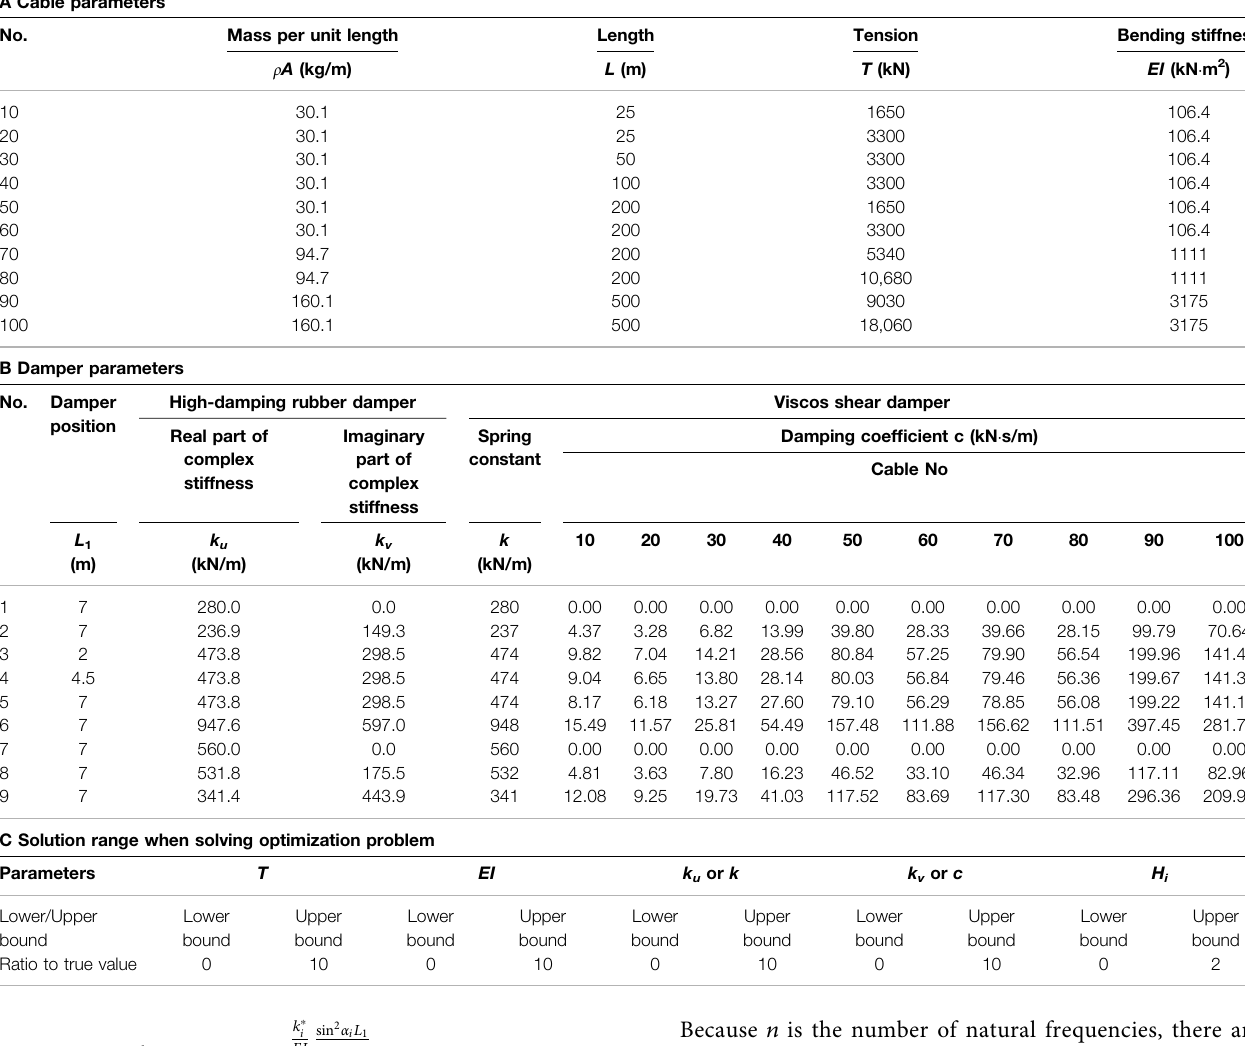
TABLE 2 | Analytical